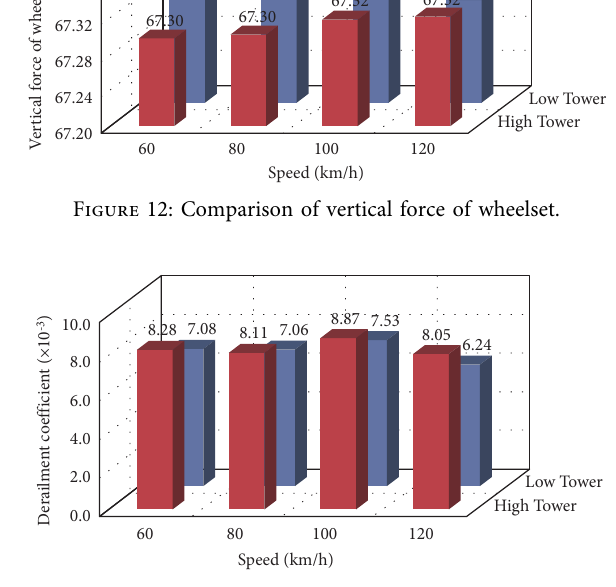
Figure 13: Comparison of derailment coefficient.